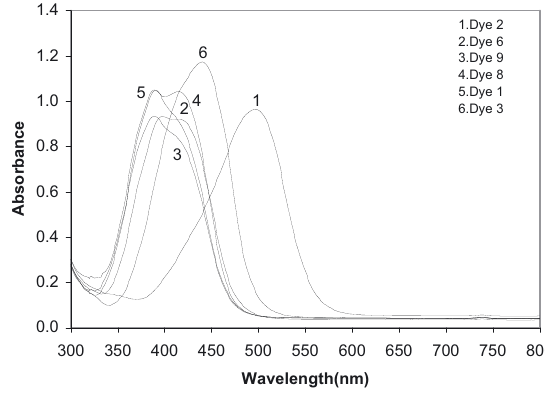
Figure 4. Absorption spectra of different dyes in DMSO. Figure 3. Absorption spectra of dye 2 in acidic and basic